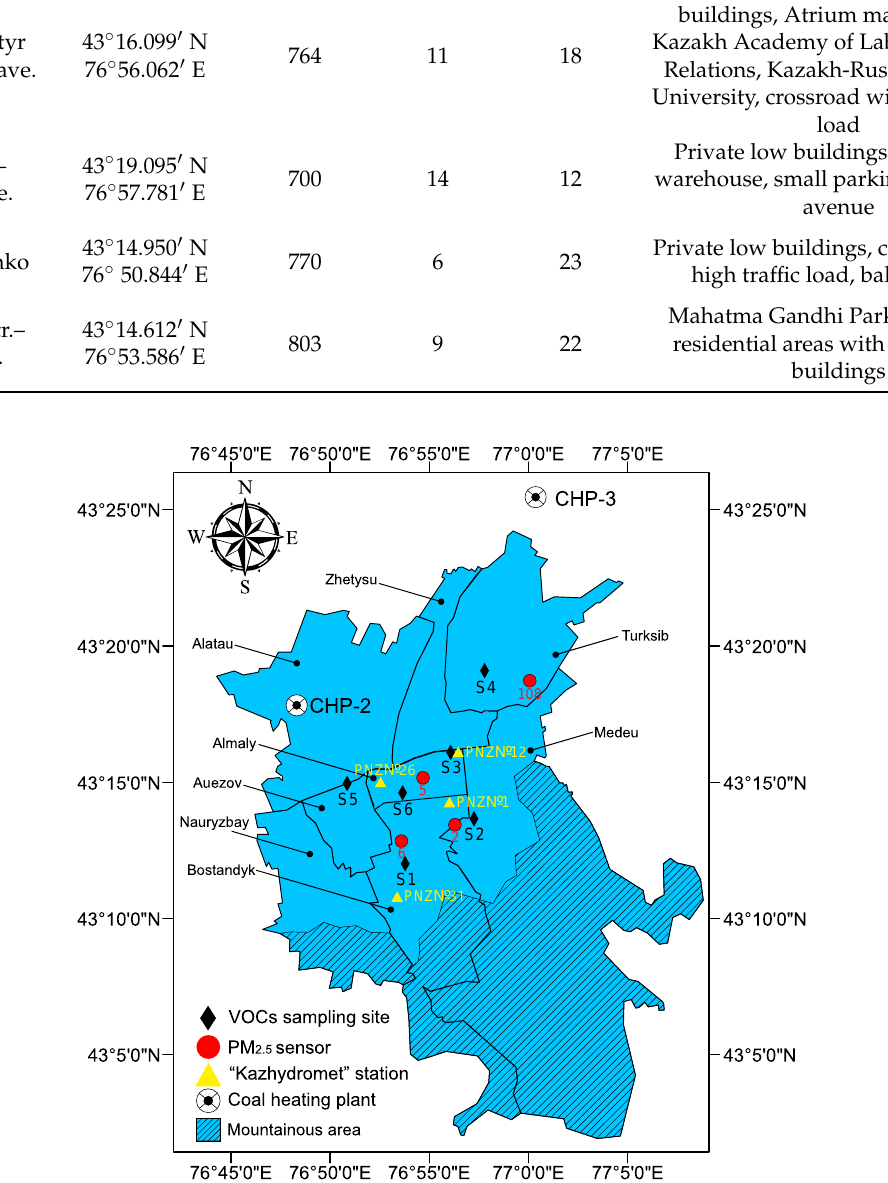
Table 2. Description of VOCs sampling periods.